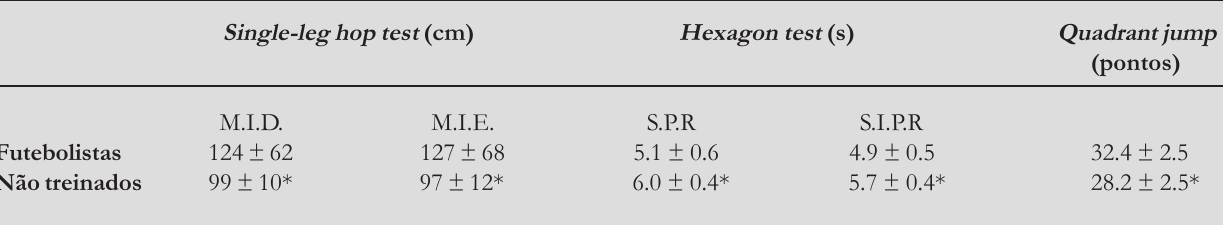
Tabela 1 - Comparação dos valores médios nos testes de performance entre o grupo